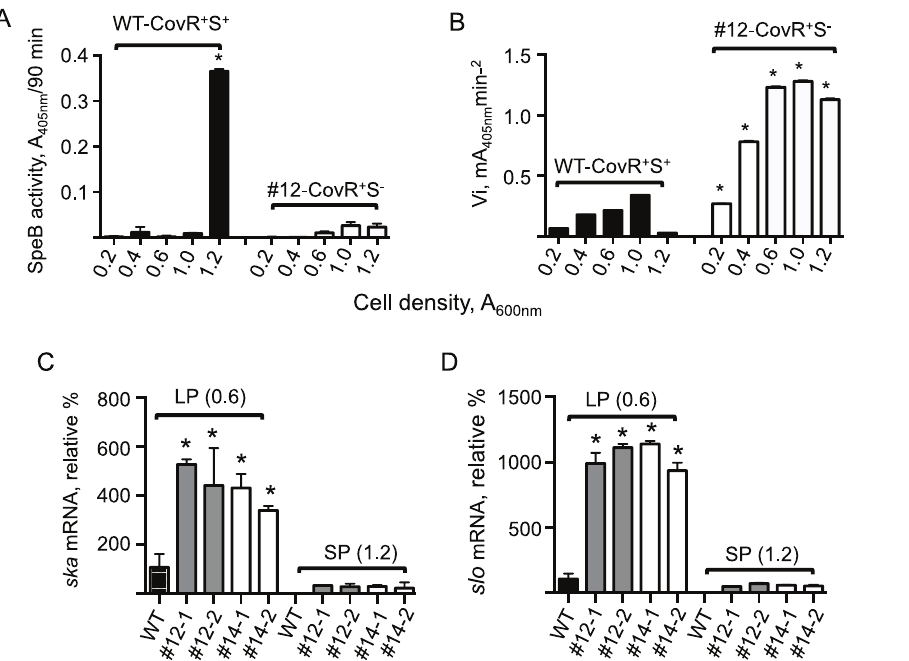
Figure 6. Gene expression in WT-5448/CovR + S + and mouse-passaged clones of 5448/CovR + S 2 in cells and in culture supernatants. (A) Levels of SpeB enzymatic activity measured spectrophotometrically in conditioned culture supernatants of WT-5448/CovR + S + and mouse- passaged 5448-CovR + S 2 strain # 12 (skin) from Table 2. Aliquots of the supernatants were sampled at various cell densities, measured as A 600nm . 5448/CovR + S + shows the highest amount of SpeB activity when grown to early-SP (A 600nm =1.2). Very little SpeB is measured during LP (A 600nm =0.2– 1.0). The data are expressed as A 405nm , reflecting hydrolysis of the chromogenic substrate, after 90 min incubation. (B) Initial rates (V i ) of hPg activation by culture supernatants sampled at various cell densities, reflecting SK activity in WT-5448/CovR + S + and mouse-passaged 5448/CovR + S 2 strain # 12 (skin). Higher amounts of SK are present in conditioned culture media of 5448/CovR + S 2 strain # 12 than in that obtained from growth of WT-5448/CovR + S + . *P , 0.01 in a two-tailed comparison of each measurement between WT-5448/CovR + S + and 5448/CovR + S 2 strain # 12 at the same cell densities. (C-D) The effect of mouse-passaged GAS 5448 on (C) ska and (D) slo gene transcription. Total RNA was isolated from washed cells harvested at mid-LP (A 600nm , 0.6) and early-SP (A 600nm , 1.2) growth. WT-5448/CovR + S + and 2 independent clones from mouse-passaged 5448/ CovR + S 2 # 12 ( # 12-1 and # 12-2) and # 14 ( # 14-1 and # 14-2) were employed for the RT-PCR assays. The % gene expression levels the mouse- passaged strains are relative to those in WT-5448/CovR + S +